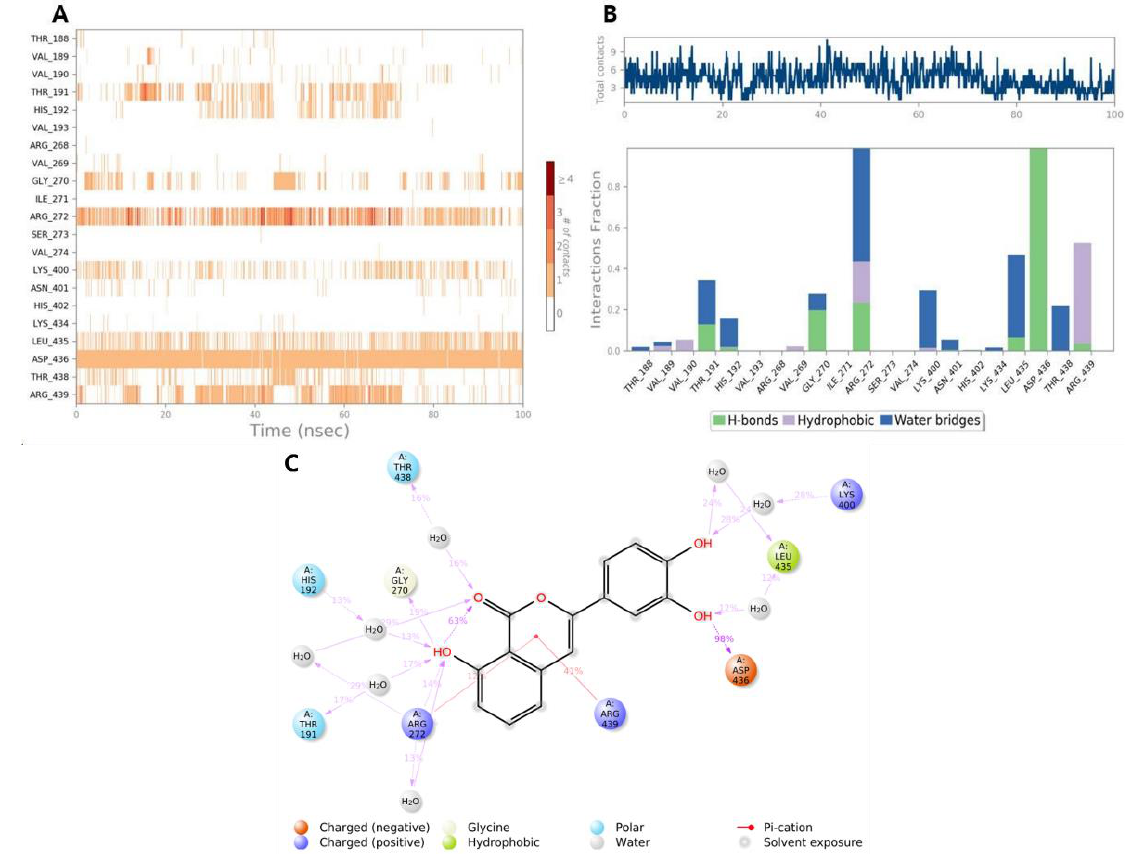
Figure 7. Protein – ligand contact analysis between compound 1 and β -glucuronidase complex (( A ), timeline and ( B ), bar chart presentations) and 2D interaction diagram ( C ).